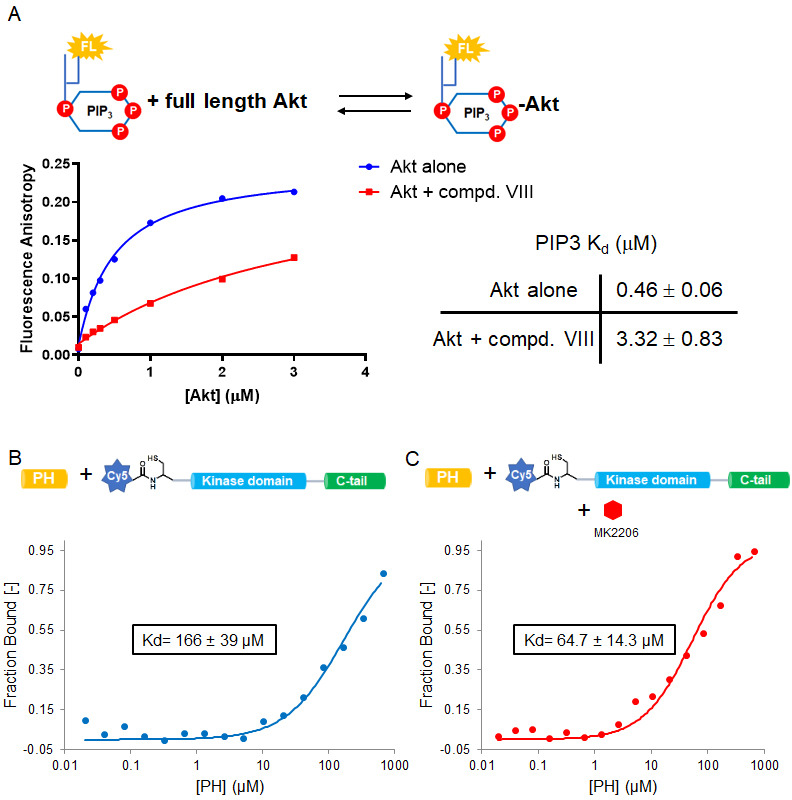
Allosteric inhibitors glue PH and kinase domains together and compete with PIP3.(A) Binding assays of soluble phospholipid PIP3 with full-length Akt in presence of 10 µM compound VIII (compd. VIII), fluorescence anisotropy measurements (n = 2) were carried out and fit to quadratic binding isotherms, and Kd values shown ± S.D. (B–C) MST measurements (n = 2) for trans-binding of varied amounts of PH domain with N-terminally Cy5-labeled Akt (aa 122–480) fragment without (B) and with 20 µM MK2206 (C), the obtained Kd values expressed in the inset boxes, S.D. shown.